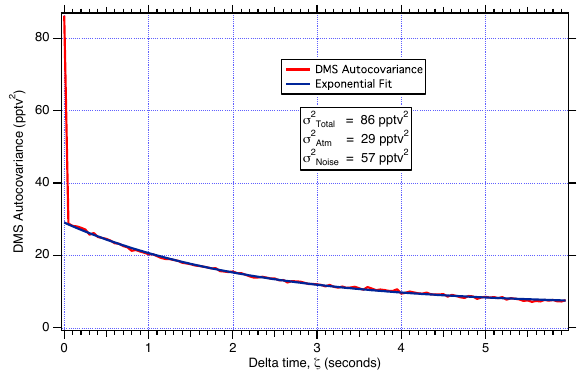
Fig. 5. Autocovariance plot for a DMS signal. Exponential ex- trapolation to ζ = 0 yields an estimate for atmospheric variance, σ 2 atm ≈ 29pptv 2 . An white noise contribution of σ 2 represents the major fraction of observed signal variance (see Sect.